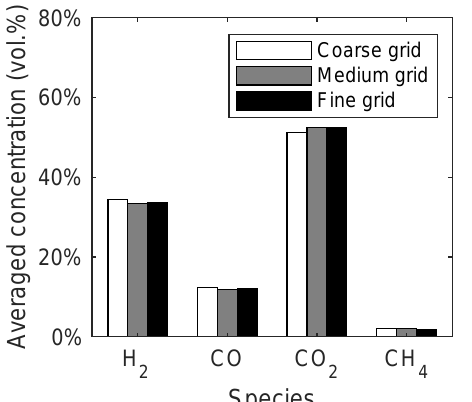
Figure 12. Syngas composition of the lab-scale fluidized bed depending on the grid